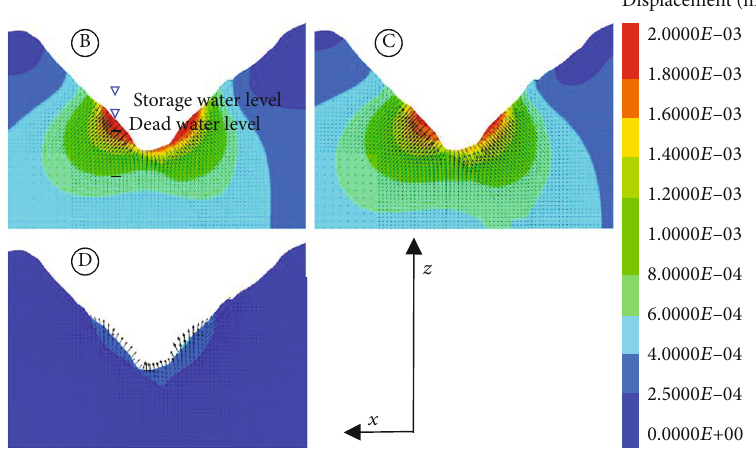
Figure 9: Distribution and evolution of pore pressure in slope.